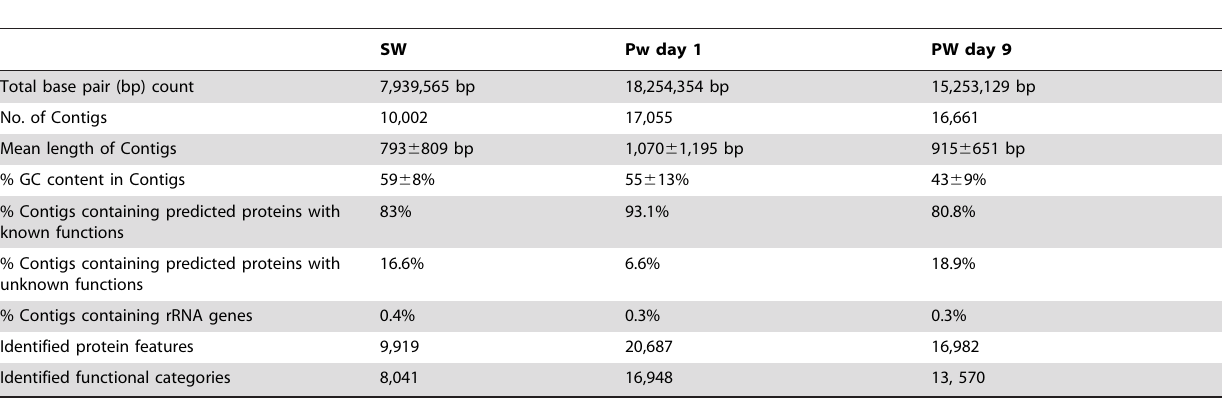
Table 1. Metagenomic sequence statistics of fracturing source water (SW), produced water day 1 (PW day 1) and produced water day 9 (PW day 9).